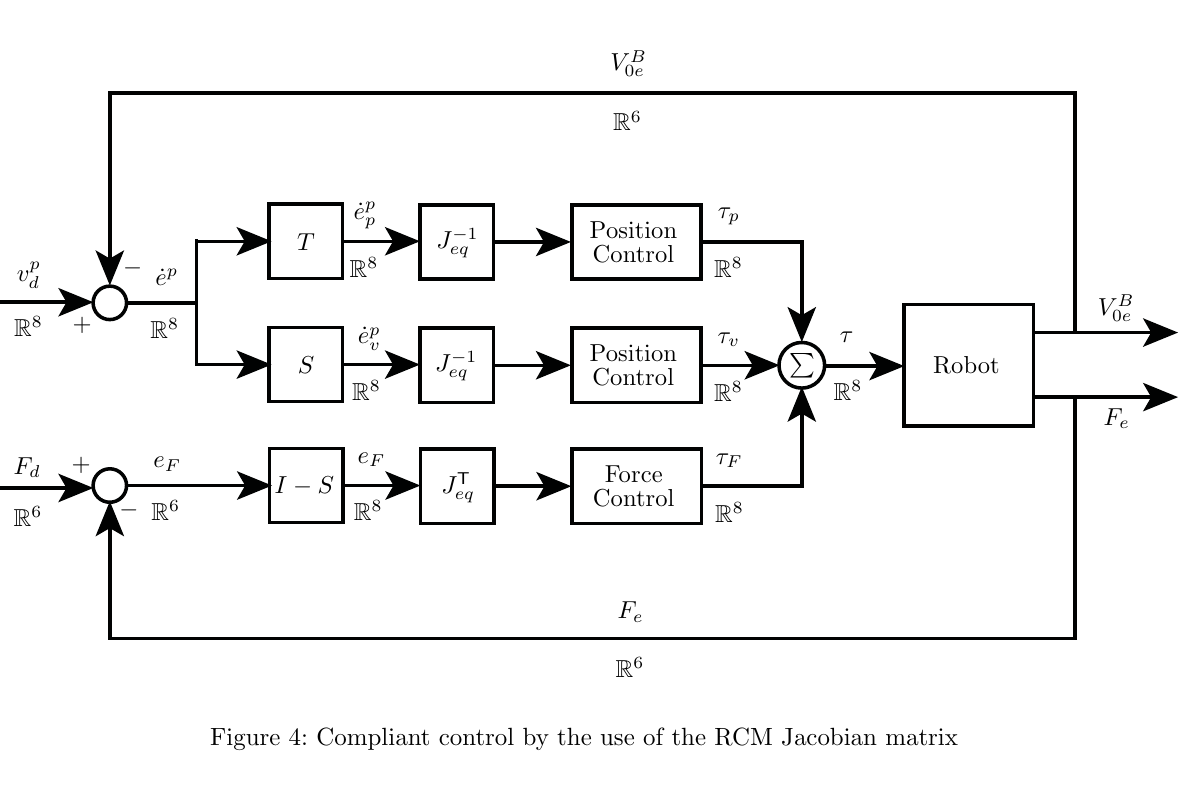
Figure 4: Compliant control by the use of the RCM Jacobian matrix